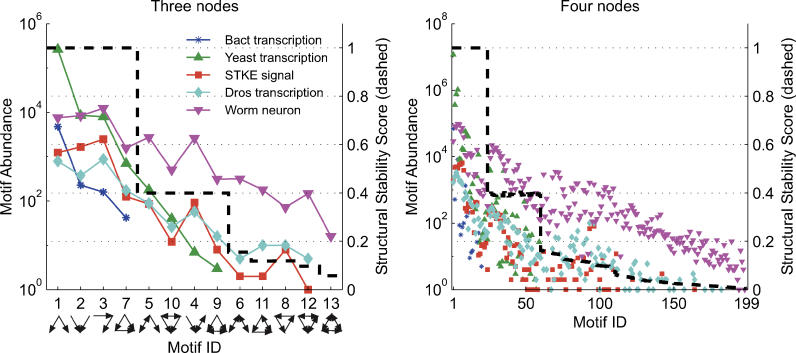
Abundance of a Motif Is Correlated with Its SSSThe number of instances of all three-node (left) and four-node (right) motifs in biological networks (log scale), and SSS (black dashed line). The motifs are sorted on the x-axis from high to low SSS.